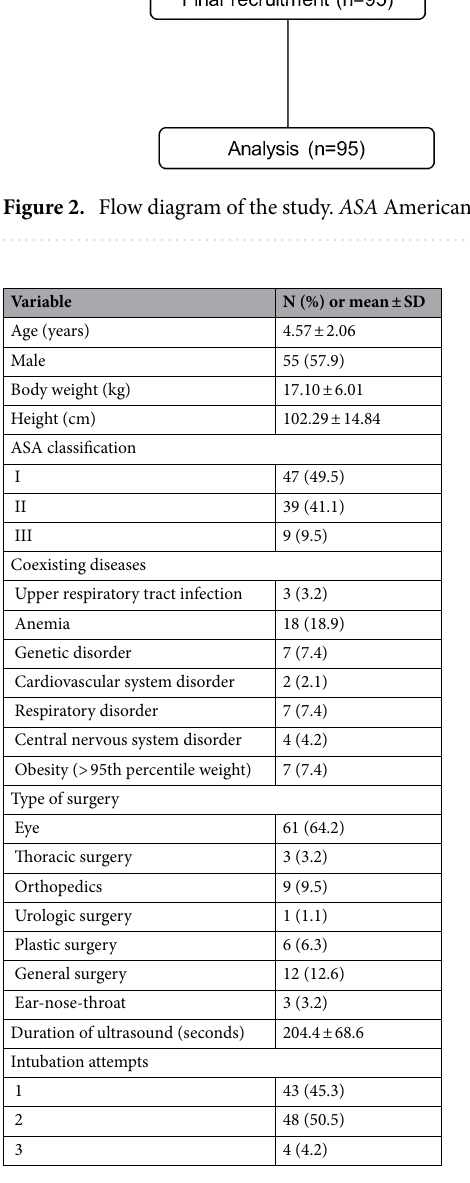
Table 1. Demographic data, surgery and anesthesia related data (N = 95). Data presented as frequency (%) and mean ± standard deviation. ASA American Society of